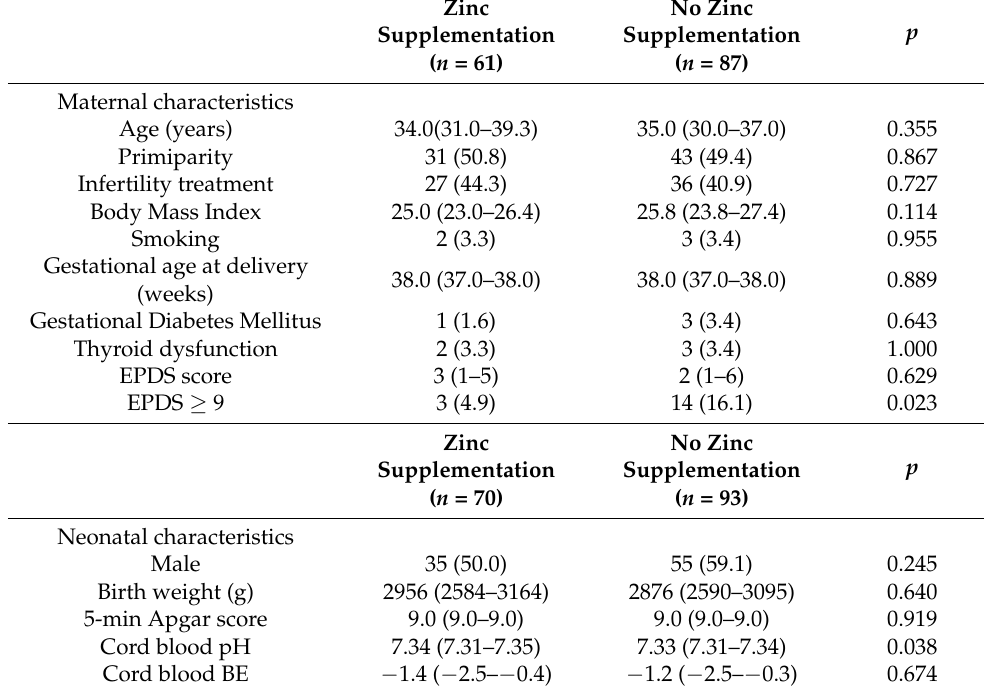
Table 2. The baseline characteristics of the cases in Analysis 2.